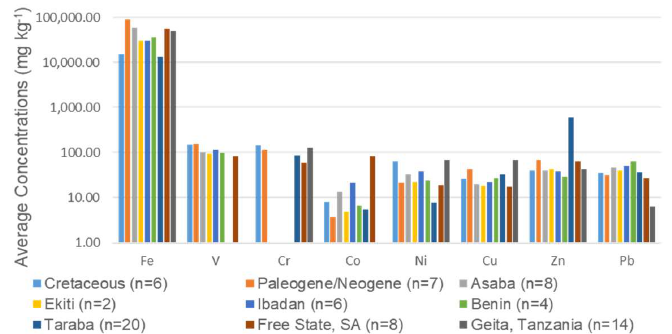
Figure 4. Plot of average trace element concentrations in Cretaceous and Paleogene / Neogene geophagic kaolinitic clays from Eastern Dahomey and Niger Delta Basins, Nigeria (this study) and from other